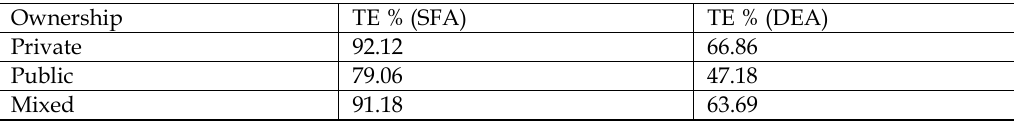
Figure 8. Average Technical Efficiency (%) by Ownership Structure Table 6. TE Estimates by Ownership